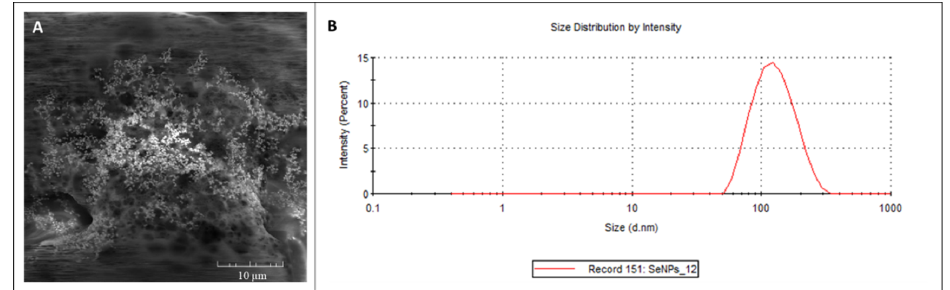
Figure 1. ( A ) SEM documentation and ( B ) size distribution of